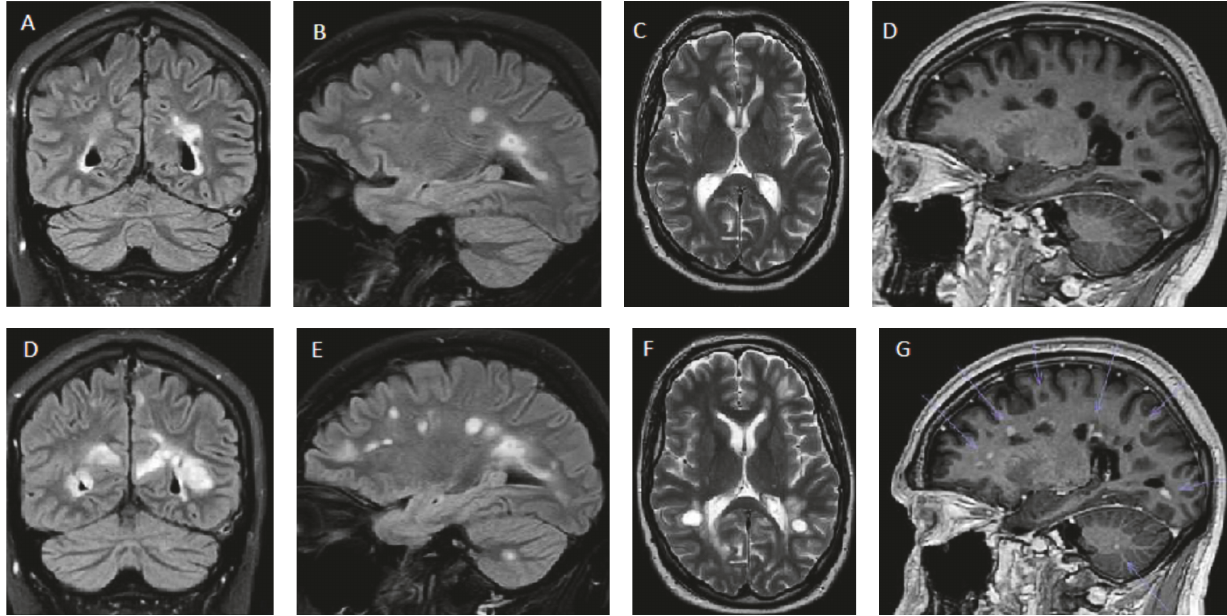
Figure 1: MRI before cessation of fingolimod in September 2016 (upper row) and 19 days after infusion of rituximab (July 2017; lower row). Coronal ( A/D ) and sagital (B/E) flair and coronal T2 (C/F) images show several new and enlarging lesions after switch to rituximab. Arrows indicate contrast enhancement on sagital T1 images ( D/G